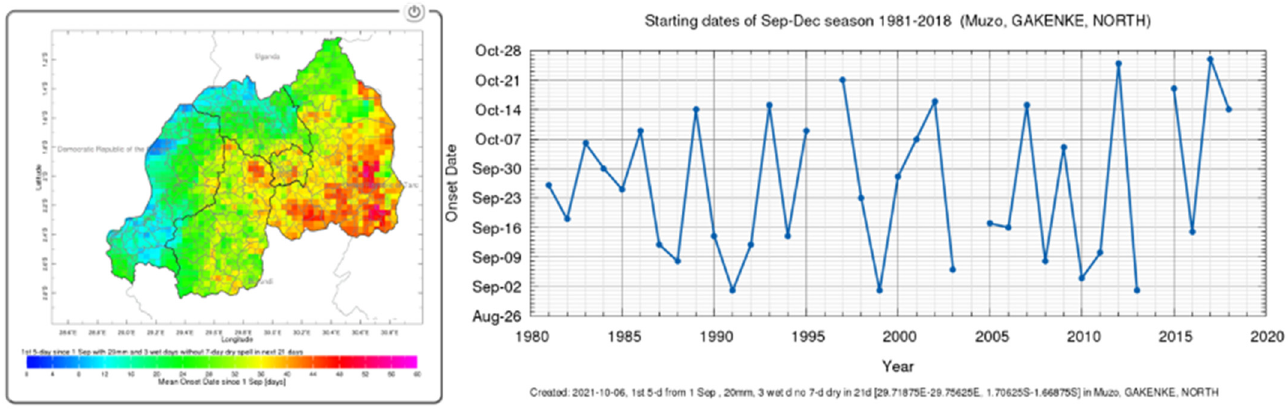
Figure 10. Onset dates displayed as a map for Rwanda ( left ) and as a time series graph for a specific location in Rwanda ( right ).